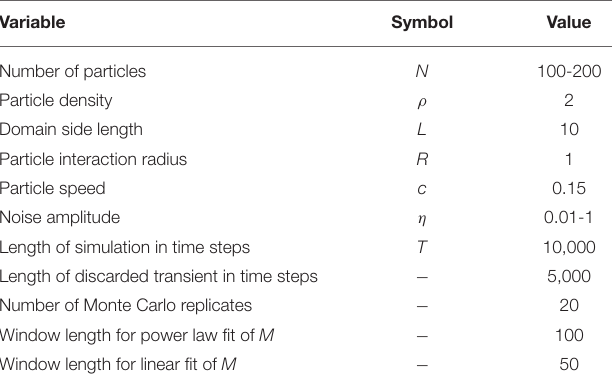
TABLE 1 | Simulation